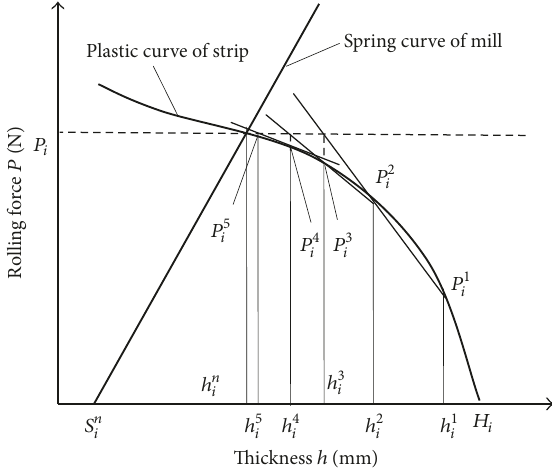
Figure 2: Schematic of simultaneous solution of the elastic- plasticity